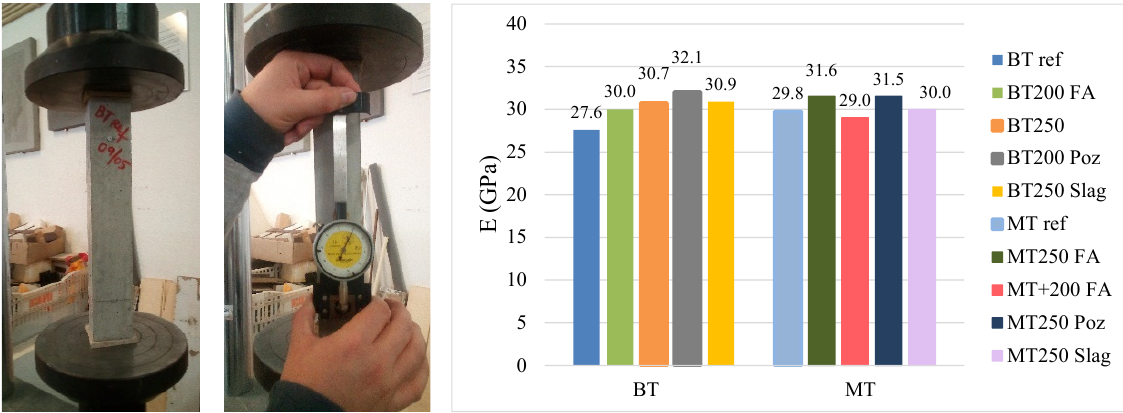
Figure 4. Young’s modulus test (left) and the values for BT and MT mixtures at 56 days